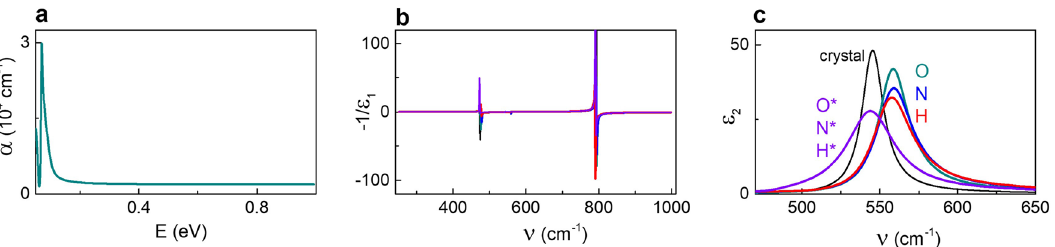
Figure 4. Optical properties in the infrared spectral range. ( a ) Absorption coefficient, ( b ) dielectric loss function, and ( c ) imaginary part of the dielectric function as a function of ( a ) photon energy or ( b , c ) wavenumber in different STO films. Data for all films overlap in ( a , b ). Data for reference crystal are shown in ( c ) for